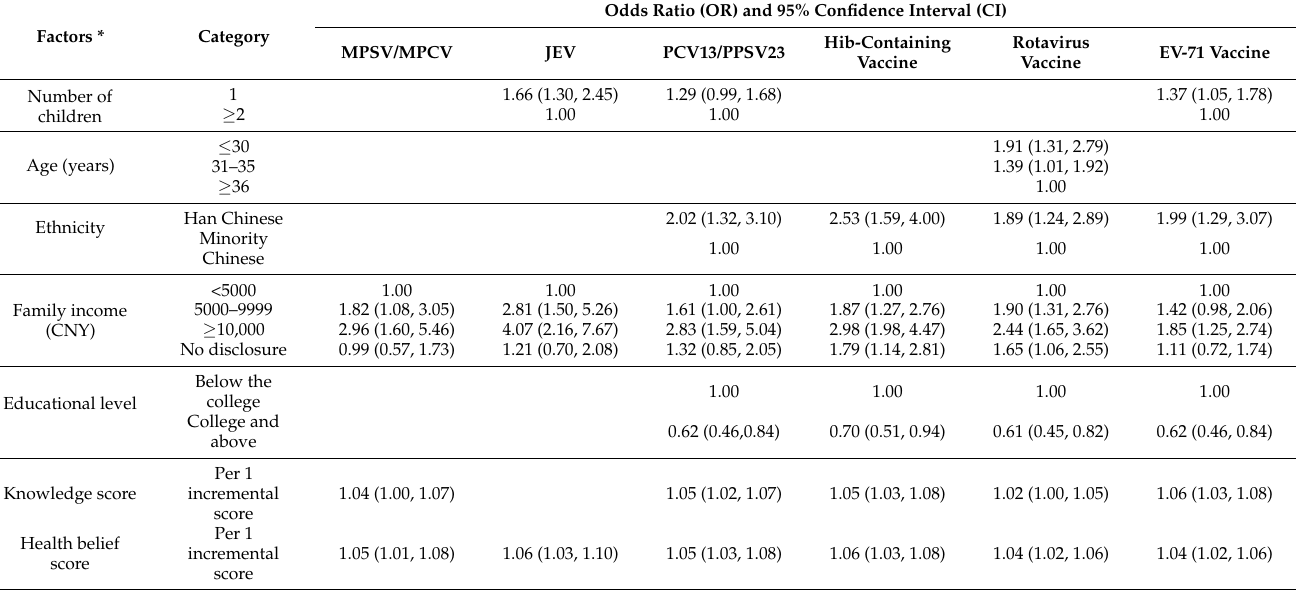
Table 4. Factors associated with vaccine uptake across demographic groups, knowledge, and health